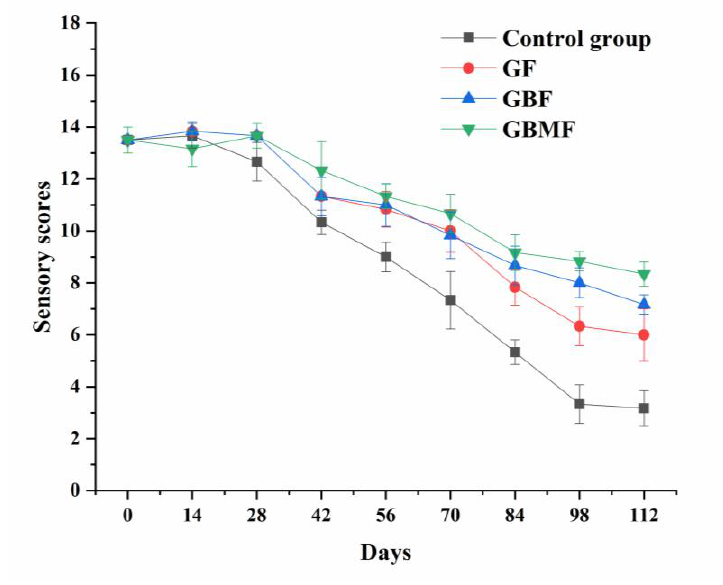
Figure 8. Changes of the sensory score of preserved eggs coated with different